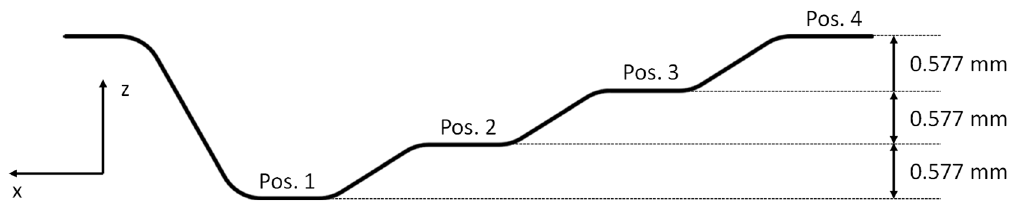
Figure 3. Shaft inside one half of the housing.